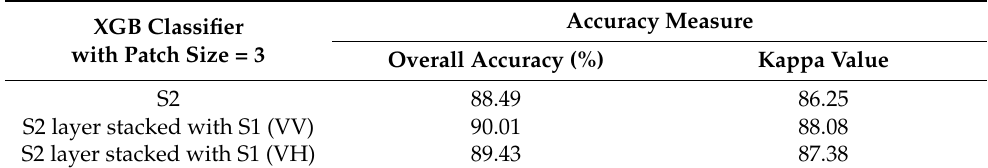
Table 4. Classification Result of Sentinel 2B (S2), Sentinel 2B (S2) layer stacked with Sentinel 1A